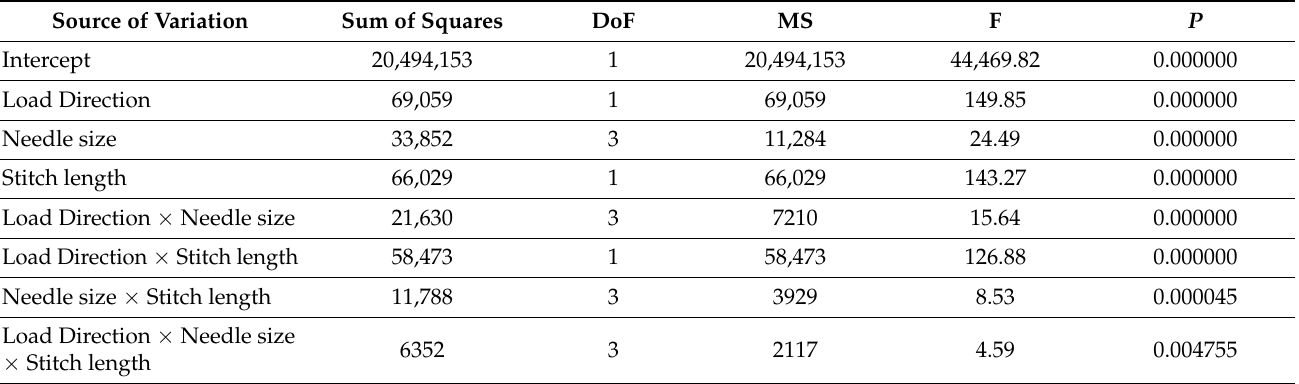
Table 3. Basic table of three-factor analysis of variance for the strength of joints of PU faux leather.